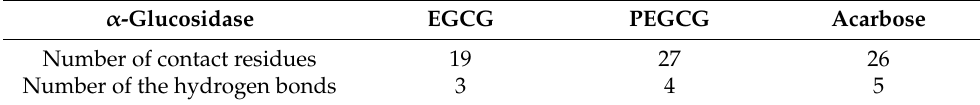
Table 8. Binding overview of the ligands with α -glucosidase. α -Glucosidase EGCG PEGCG Acarbose Number of contact residues 19 27 26 Number of the hydrogen bonds 3 4